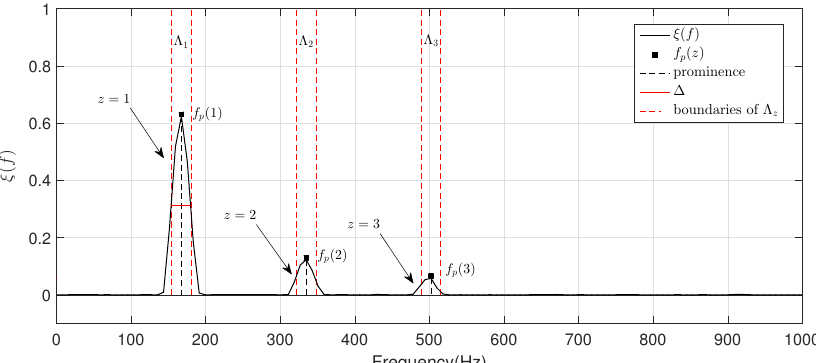
Figure 7. Example of the proposed two-step procedure to classify between MP and PP wheezing when η > 1 from the example of MP wheezing shown in Figure 1B. Note that the arrows indicate the narrowband spectral peaks that compose the wheezing. In this case, the wheezing is classified as MP because all spectral peaks are harmonically related.